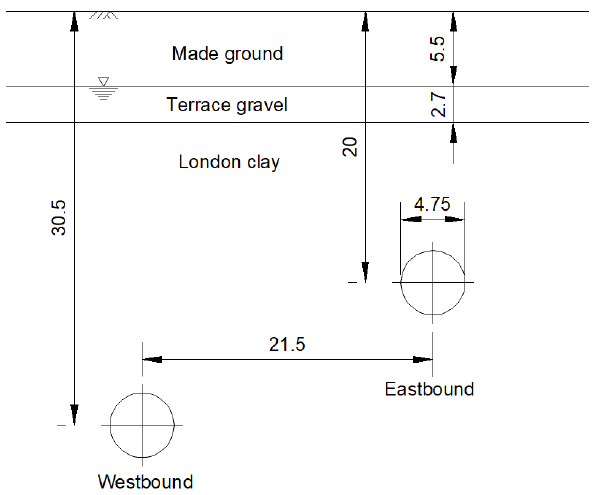
Figure 12. Geological profile and layout of twin tunnels beneath St. James Park (adapted after